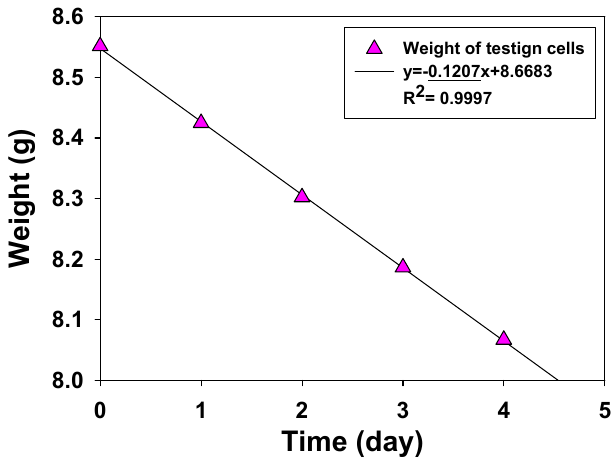
Figure 5. Typical water vapor transfer rate data of a PAMPS membrane.